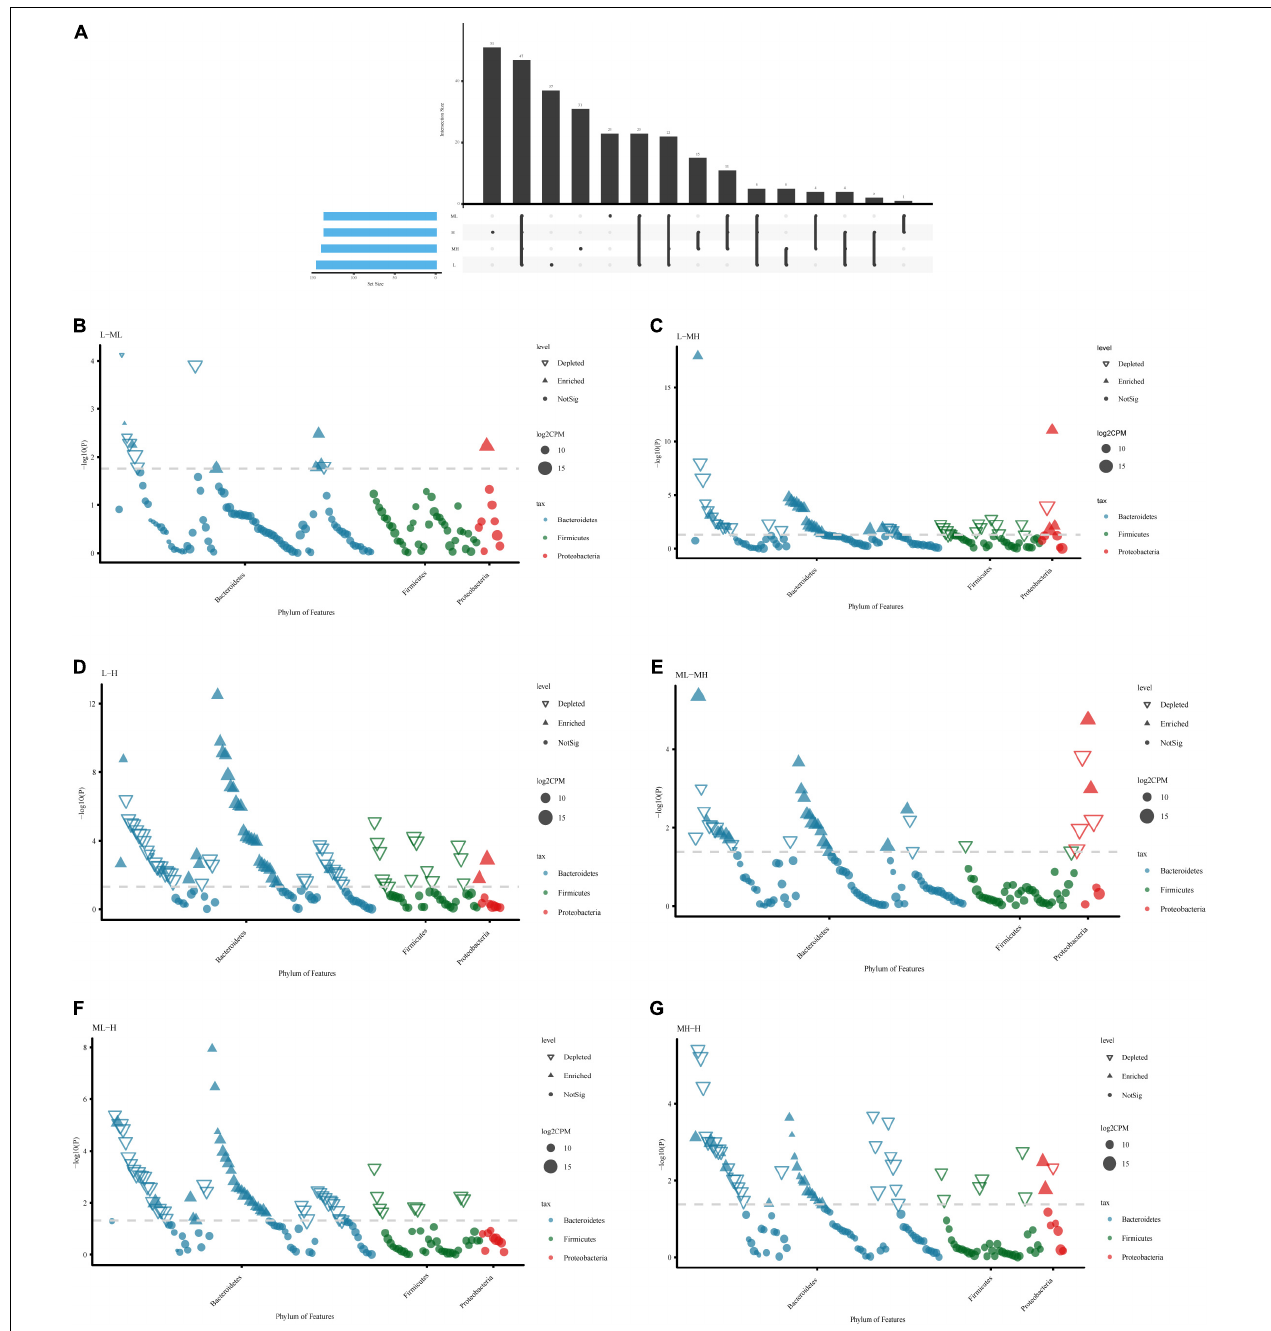
FIGURE 3 | Bacterial variation comparison analysis of rumen samples between yaks fed diets with different protein levels. (A) UpSet plot of the ASV count in each group. Comparative analysis between two groups: (B) L vs. ML; (C) L vs. MH; (D) L vs. H; (E) ML vs. MH; (F) ML vs. H; (G) MH vs.